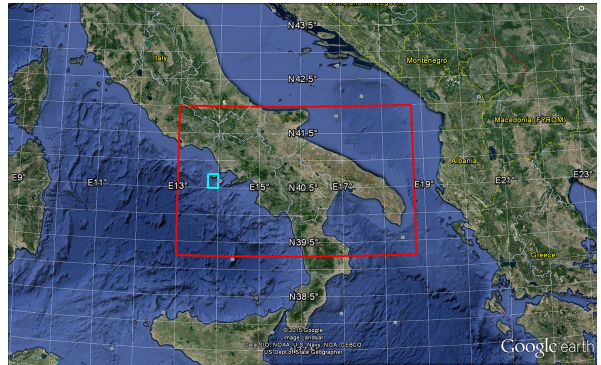
Figure 3. Southern Italy region (boxed area) considered for the case study over sea surface. The cyan box is the SEVIRI pixel used to compare the retrieved T s against AVHRR